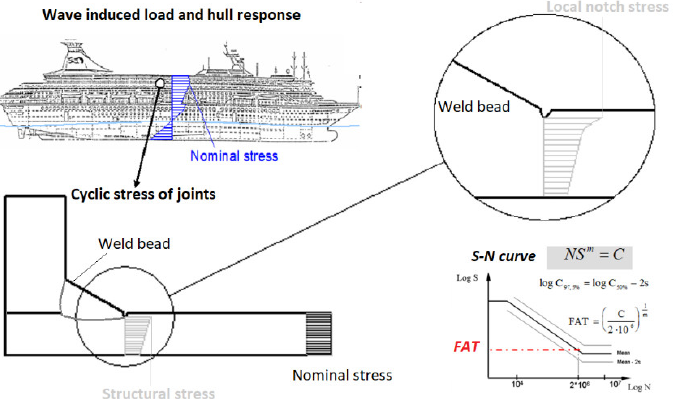
Figure 3. Fatigue design of ship welded structures.